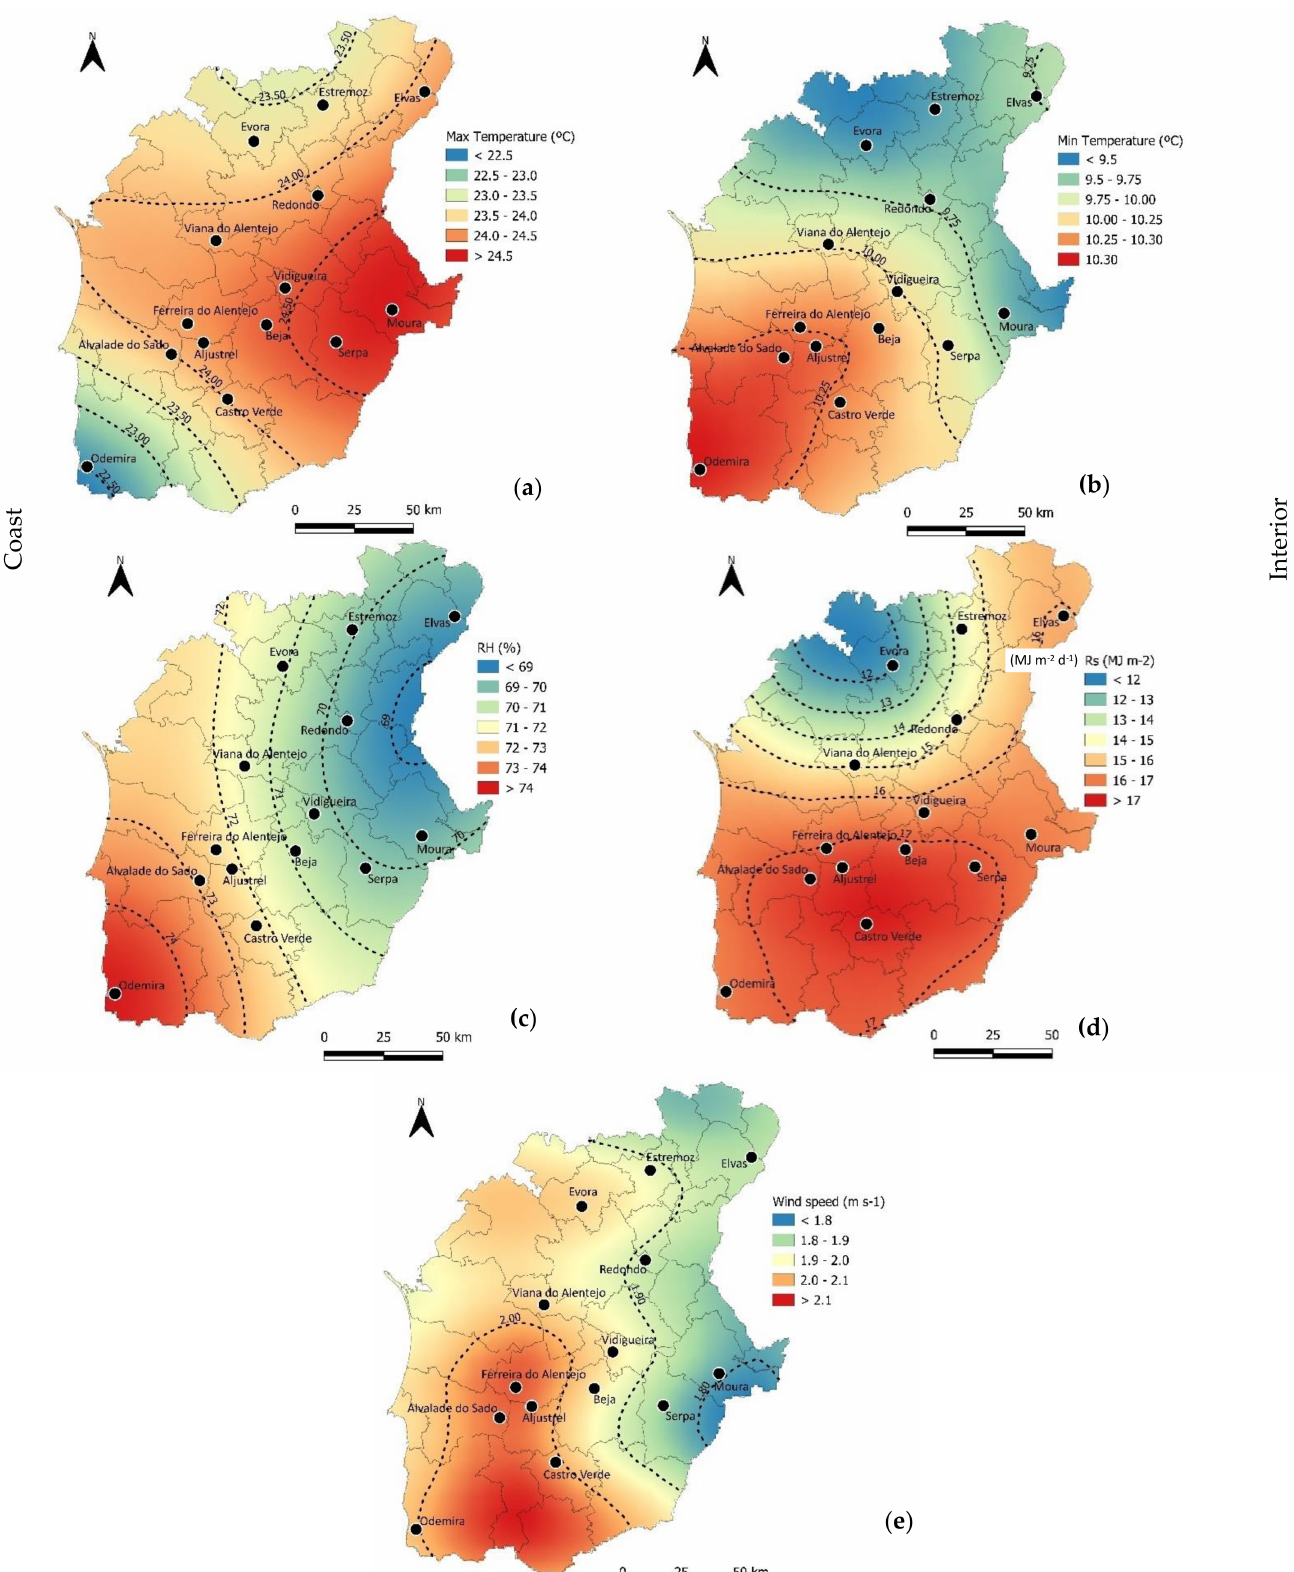
Figure 2. Annual climate of maximum ( a ) and minimum ( b ) temperatures, mean relative humidity ( c ), solar radiation ( d ) and mean wind speed ( e ) over